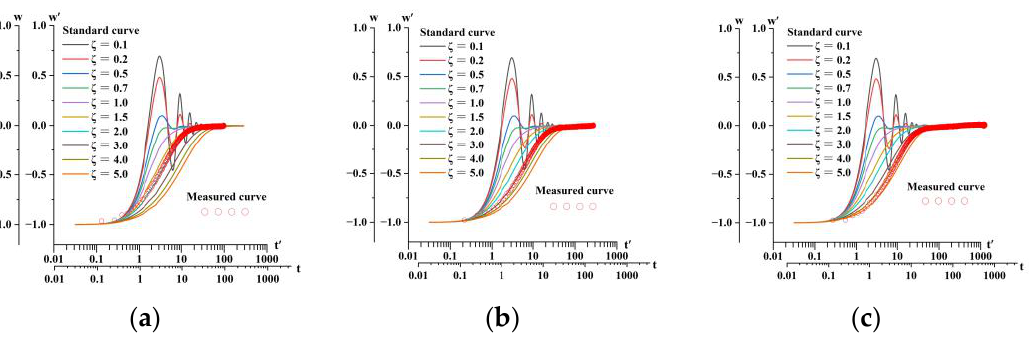
Figure 6. Partial slug test Kipp model matching fitting diagram under none well-skin model condi- tions. ( a ) N-Sls2. ( b ) N-Slm2. ( c ) N-Sll3. Table 4. Calculation results of permeability coefficients of the Kipp model in the slug test. None Well-skin None Well-Skin ρ s = 3.75 Test